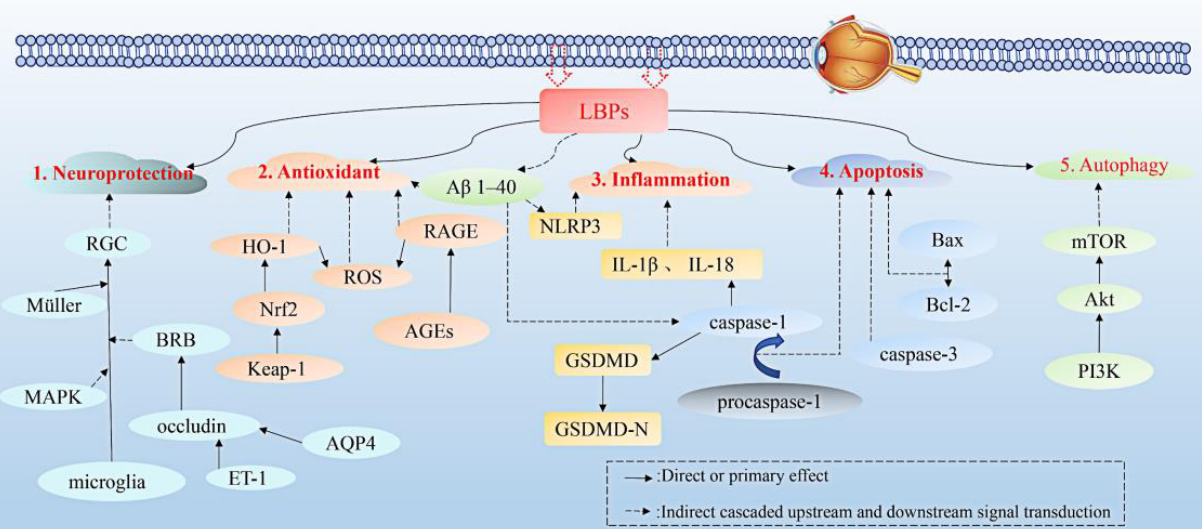
Figure 5. The pathway of LBPs in improving vascular retinopathy. The protective effects of LBPs are mainly attributed to neuroprotection, antioxidant, inflammation, apoptosis, and autophagy.